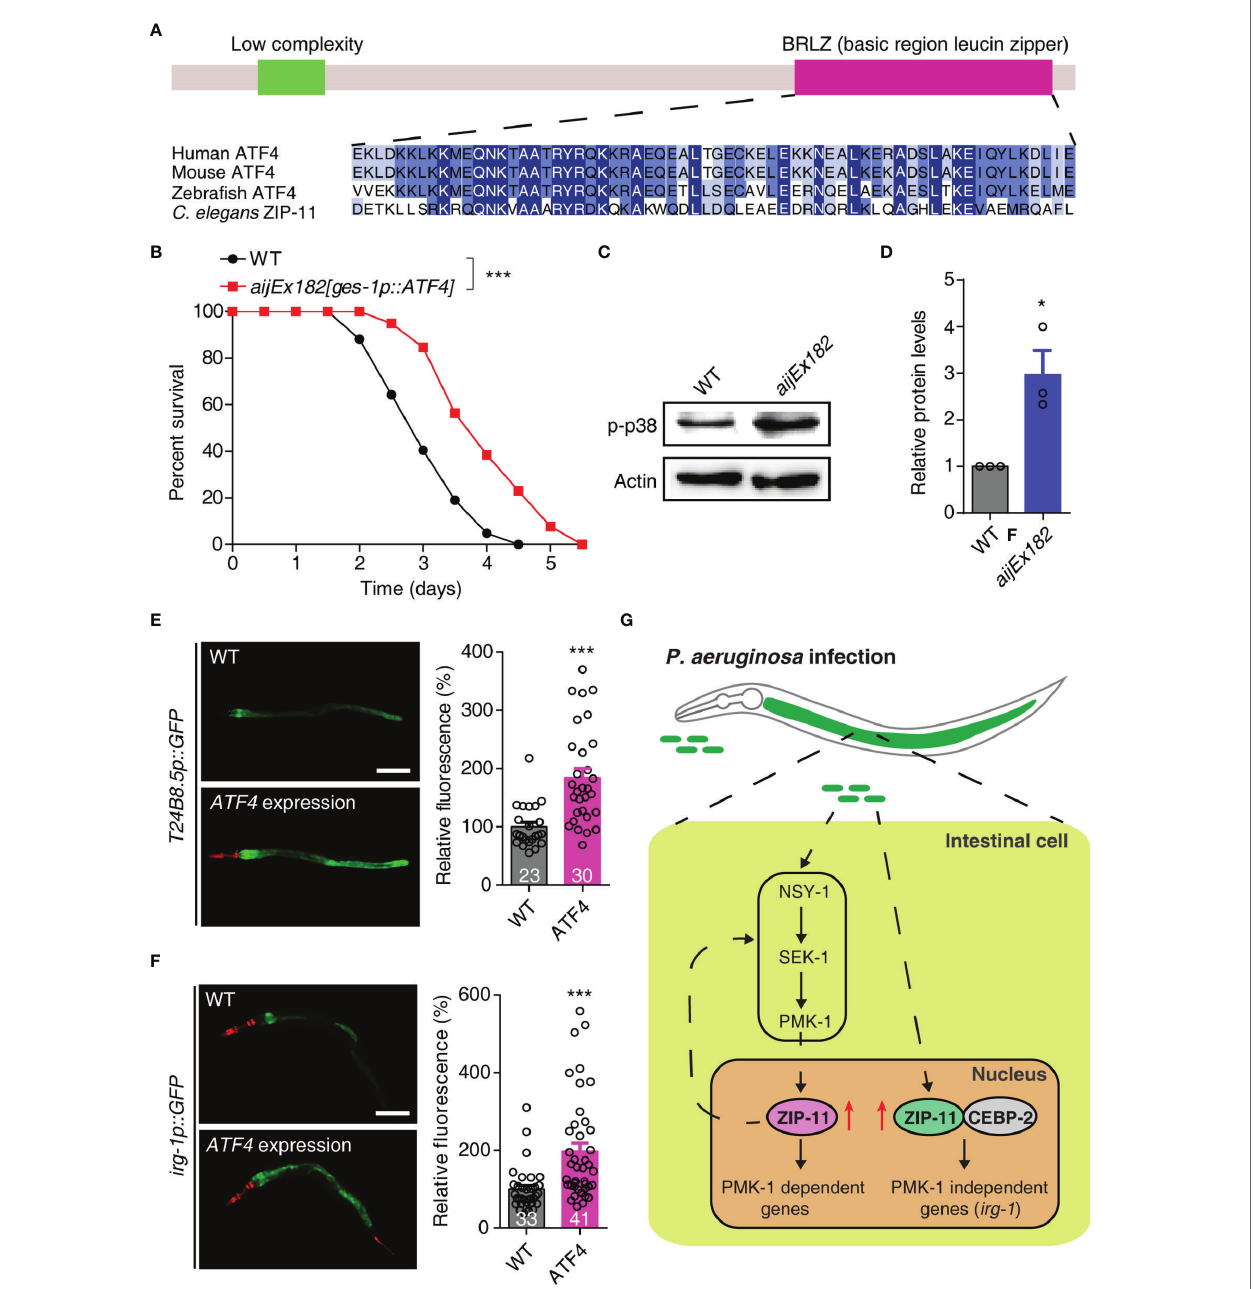
FIGURE 5 | Human ATF4 can functionally substitute for C. elegans ZIP-11 in immune regulation. (A) Schematic of the C. elegans ZIP-11 protein showing the domain information predicted by SMART (http://smart.embl-heidelberg.de) (top) and the BRLZ domain multiple sequence alignment of ZIP-11 homologues from major metazoans. (B) WT and aijEx182[ges-1p::ATF4] worms were exposed to P. aeruginosa PA14 and scored for survival. (C) Western blot analysis of p38 phosphorylation levels in WT and aijEx182[ges-1p::ATF4] worms. (D) Quanti fi cation of the protein expression levels using the software program ImageJ. (E) Representative images and quanti fi cation of T24B8.5p::GFP in WT and ATF4-expressed worms. myo-2p::mcherry shows the red fl uorescence of pharynx as a marker for the transgene. The number of animals analysed is indicated. Scale bar: 200 m m. (F) Representative images and quanti fi cation of irg-1p::GFP in WT and ATF4-expressed worms. myo-2p::mcherry (pharynx) and lin-44p::mcherry (tail) shows the red fl uorescence as markers for the transgene. The number of animals analysed is indicated. Scale bar: 200 m m. (G) Proposed model of innate immune regulation by ZIP-11. Upon P. aeruginosa infection, the intestinal bZIP transcription factor ZIP-11 is induced, subsequently constitutes a feedback loop with PMK-1/p38 pathway and interacts with CEBP-2, further promote the expression of immune genes and enhance host defense. Data are presented as mean ± SEM. Statistical signi fi cance was determined by log-rank test (B) or Student ’ s t -test (D – F) . *p < 0.05, ***p < 0.001 compared with respective controls unless speci fi cally indicated. Please see Table S4 in Supplementary Material for detailed statistical analysis of killing assay